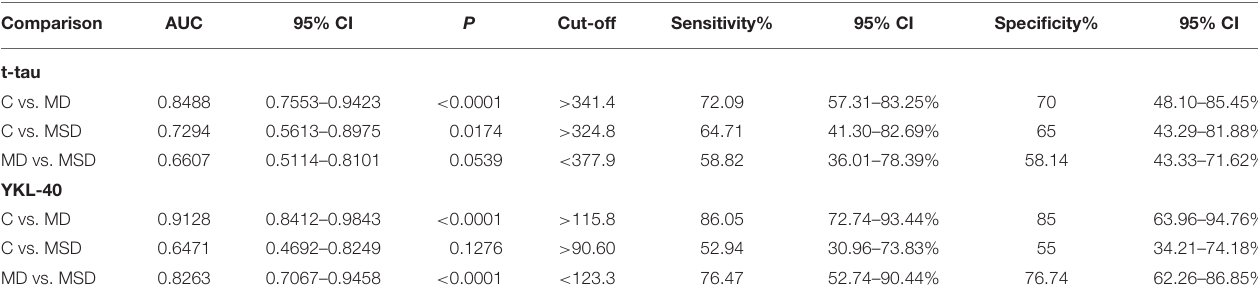
TABLE 4 | ROC analysis of serum t-tau and YKL-40 compared between mild dementia (MD), moderate to severe dementia (MSD), and control group.